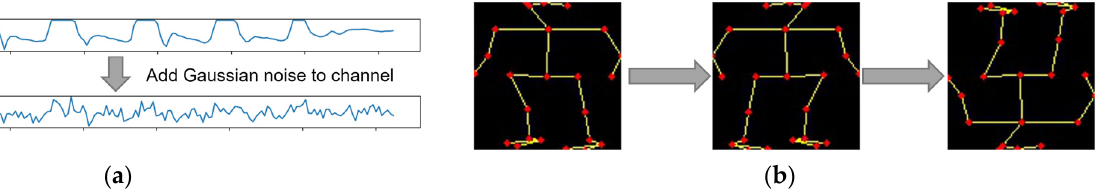
Figure 8. Input data distortion: ( a ) adding Gaussian noise to one channel of an accelerometer sensor and ( b ) a flipped image from left to right, bottom to top.